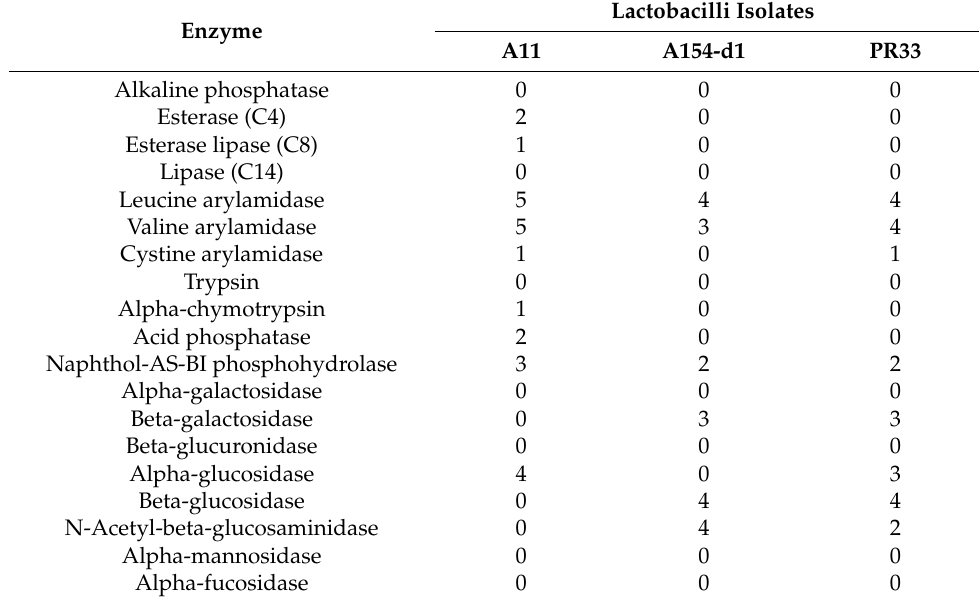
Table 2. Enzymatic activity of selected